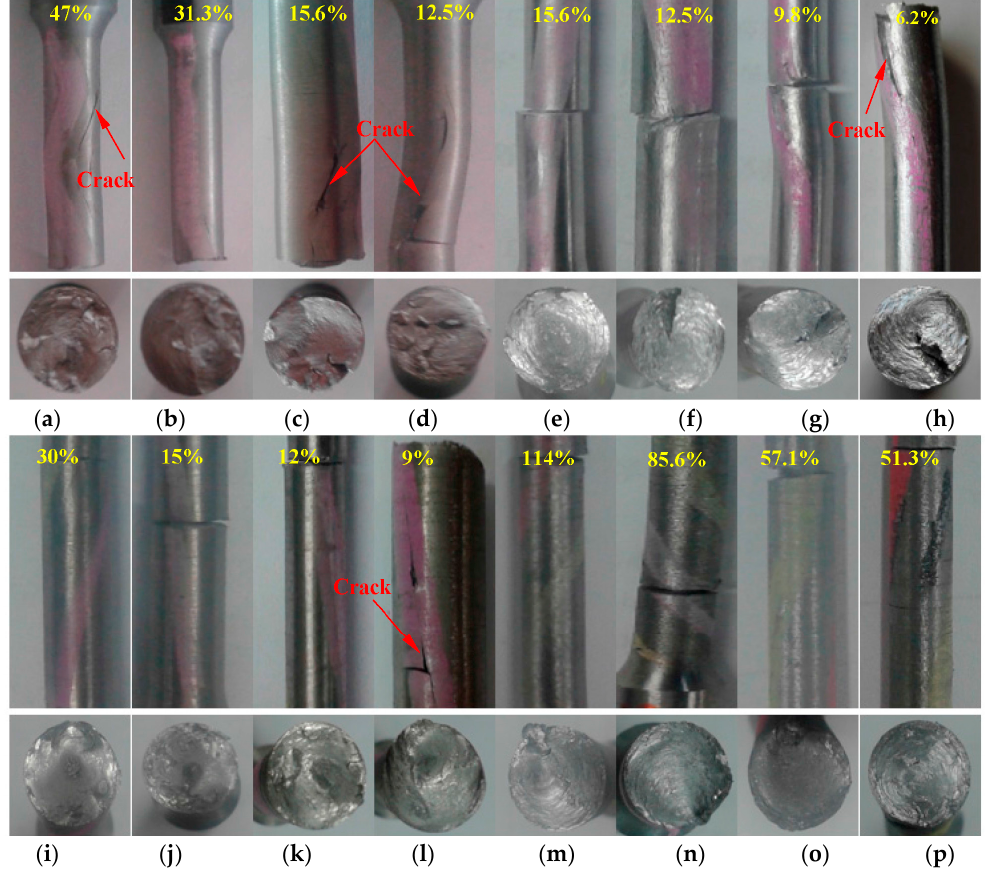
Figure 10. Failure modes under cyclical shear loading. ( a ) Q235-2; ( b ) Q235-3; ( c ) Q235-4; ( d ) Q235-5; ( e ) AL-1; ( f ) AL-2; ( g ) AL-3; ( h ) AL-4; ( i ) SS-1; ( j ) SS-2; ( k ) SS-3; ( l ) SS-4; ( m ) LYS-2; ( n ) LYS-3; ( o ) LYS-4; ( p ) LYS-5.